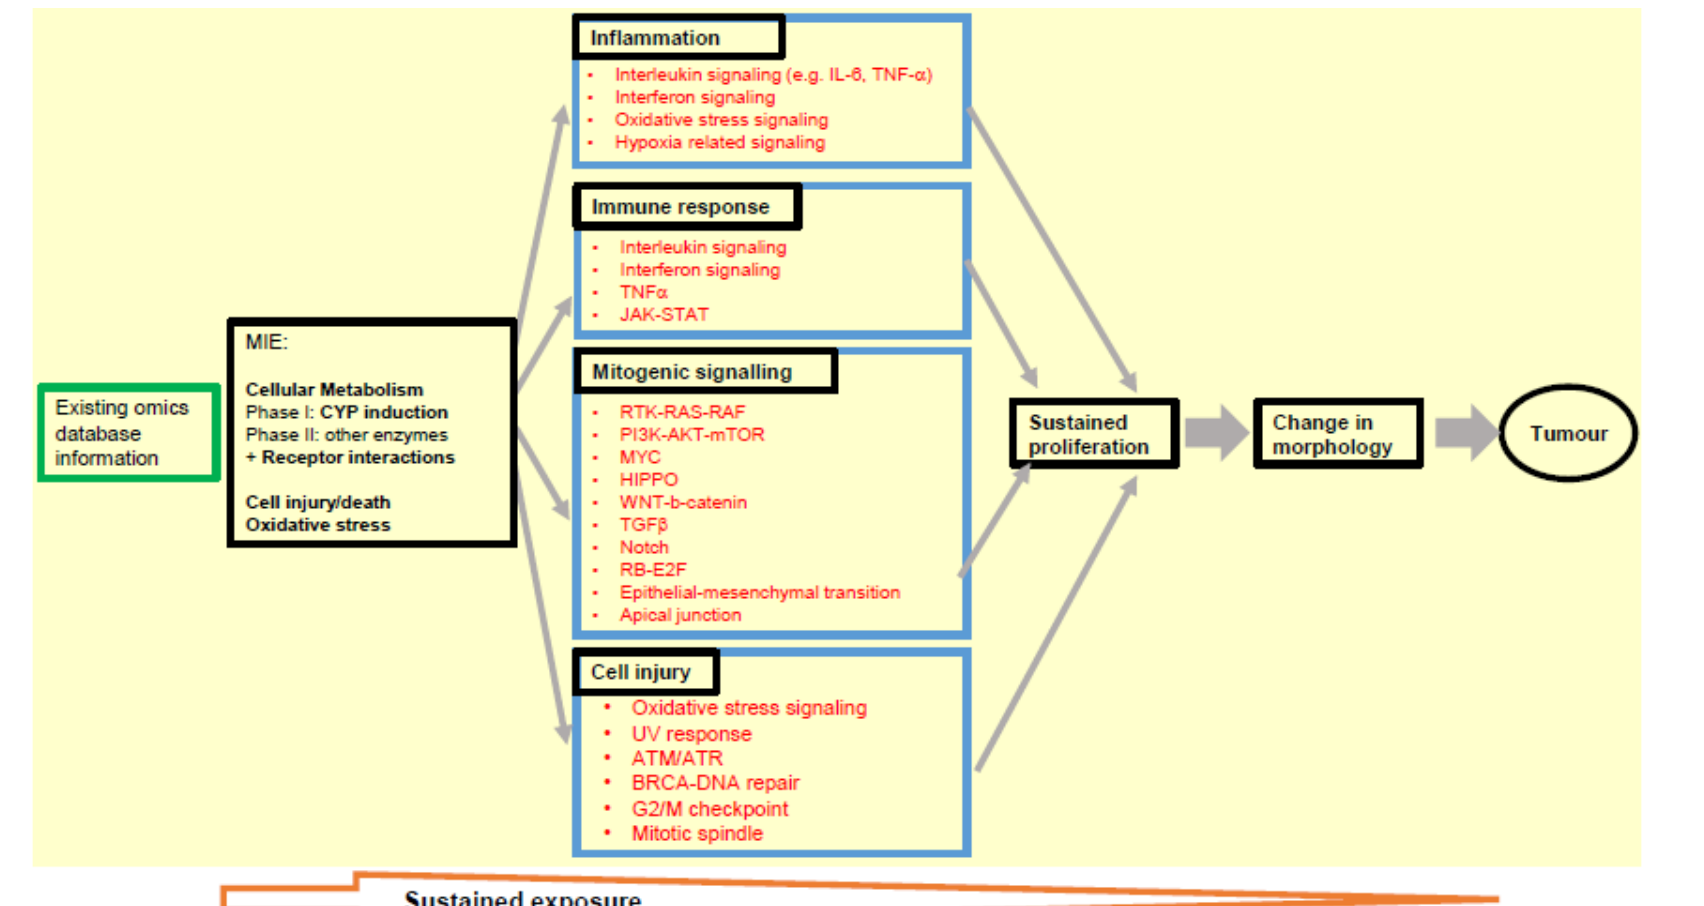
Figure 3. Pivotal omics markers proposed to be monitored in assay tools that address the key events of inflammation, immune response, mitogenic signalling and cell injury, in the NGTxC IATA (yellow section). Signalling pathways contributing carcinogenesis (red) were allocated to MIE and KEs in the IATA. Aberrant regulation of these signalling pathways should be covered by the transcriptomics to identify the possible phenotypic changes, and examples of useful tools and databases for the early key event pre-screening are provided in the main text.